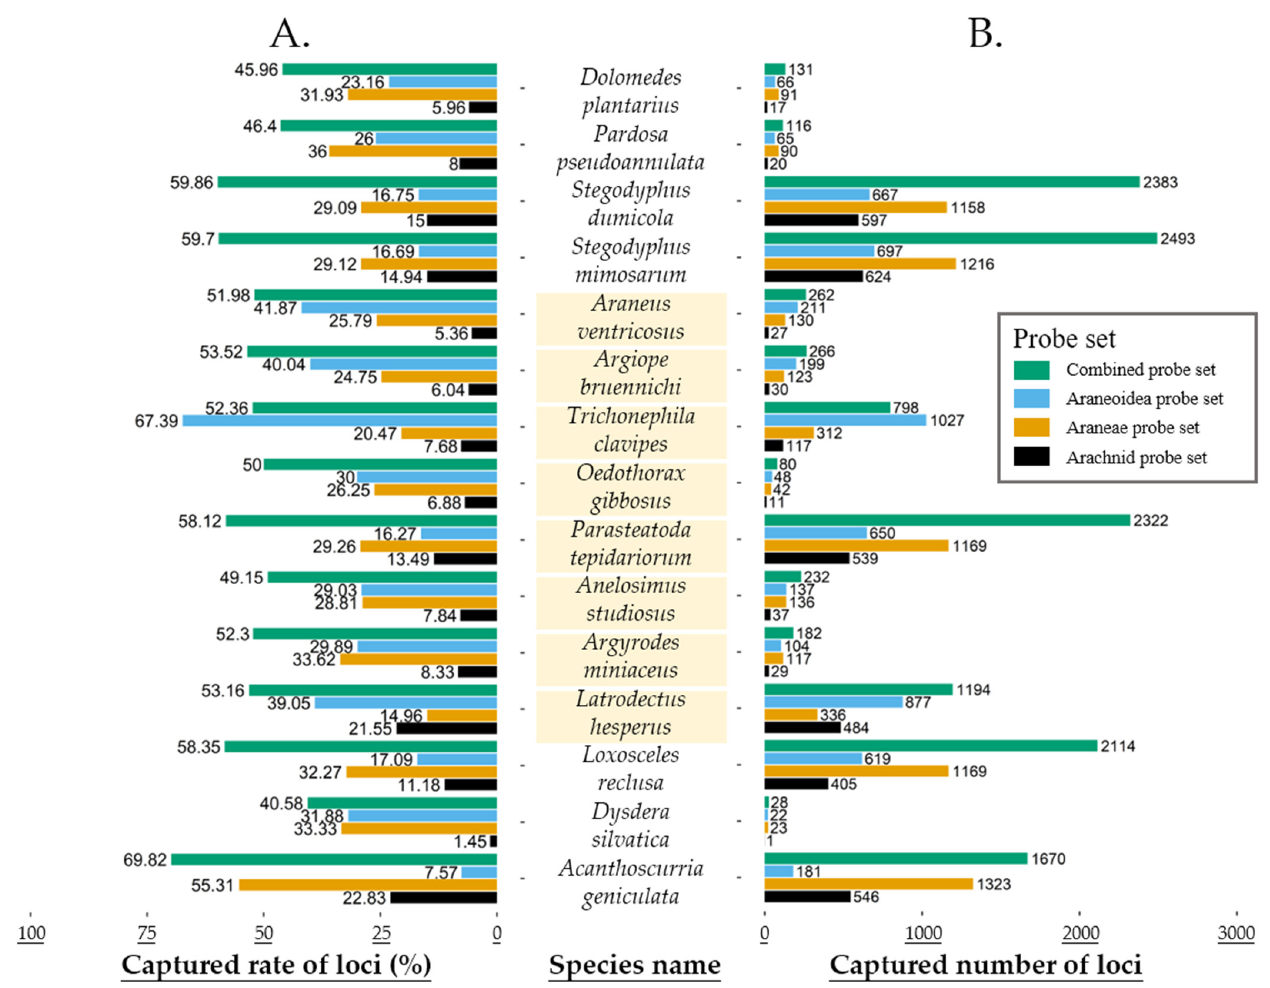
Figure 2. Comparison of all three probe sets with the combined probe set. Capture rate of loci ( A ) and captured loci number ( B ) when each probe set aligned with simulated contigs using the sequences of the combined probe set.